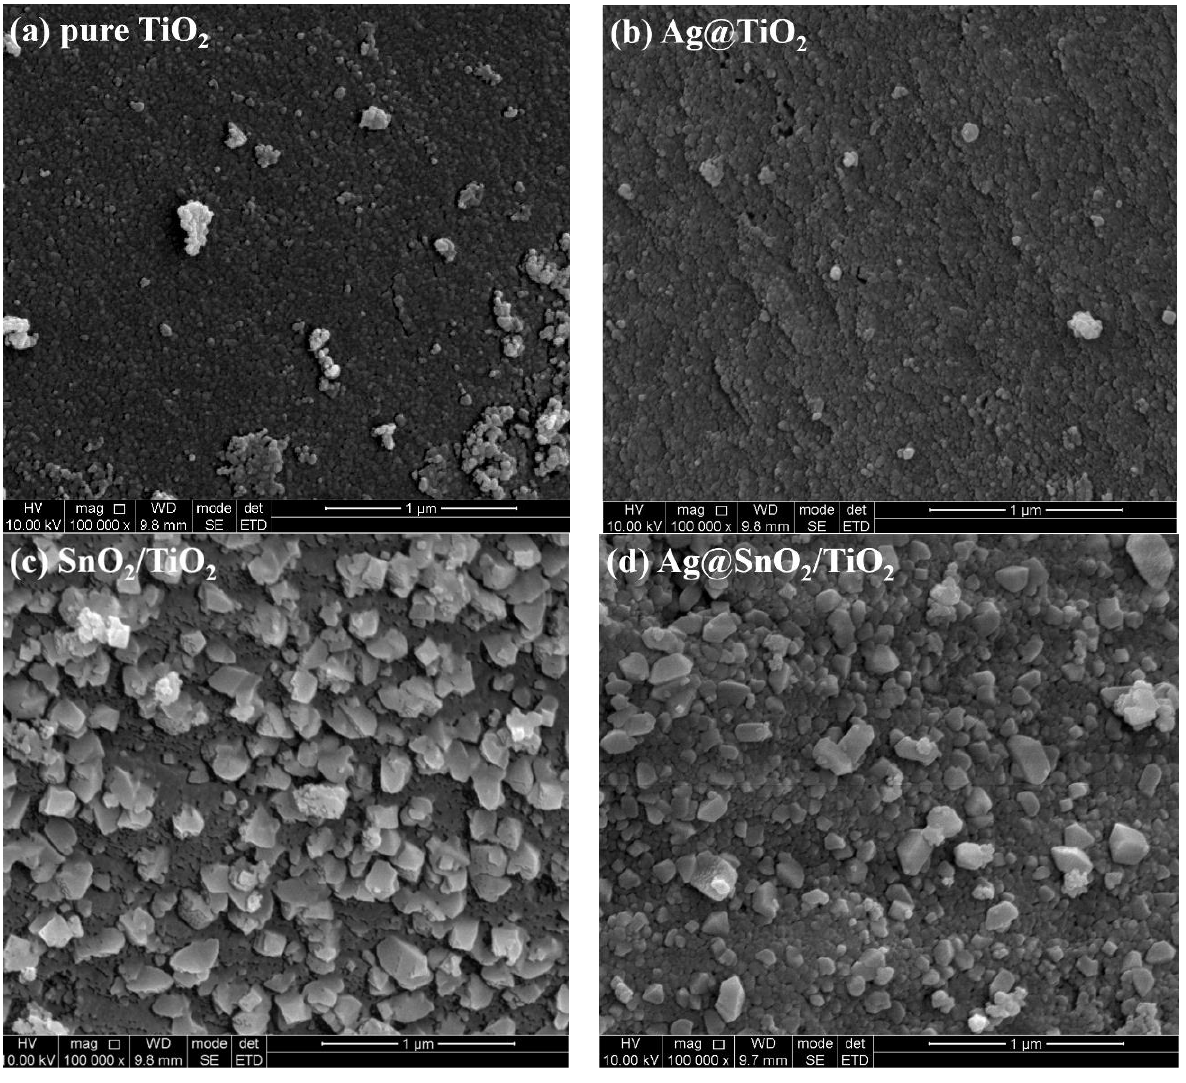
Figure 2. SEM images of pure TiO 2 ( a ), Ag@TiO 2 ( b ), SnO 2 /TiO 2 ( c ) and Ag@SnO 2 /TiO 2 ( d ).